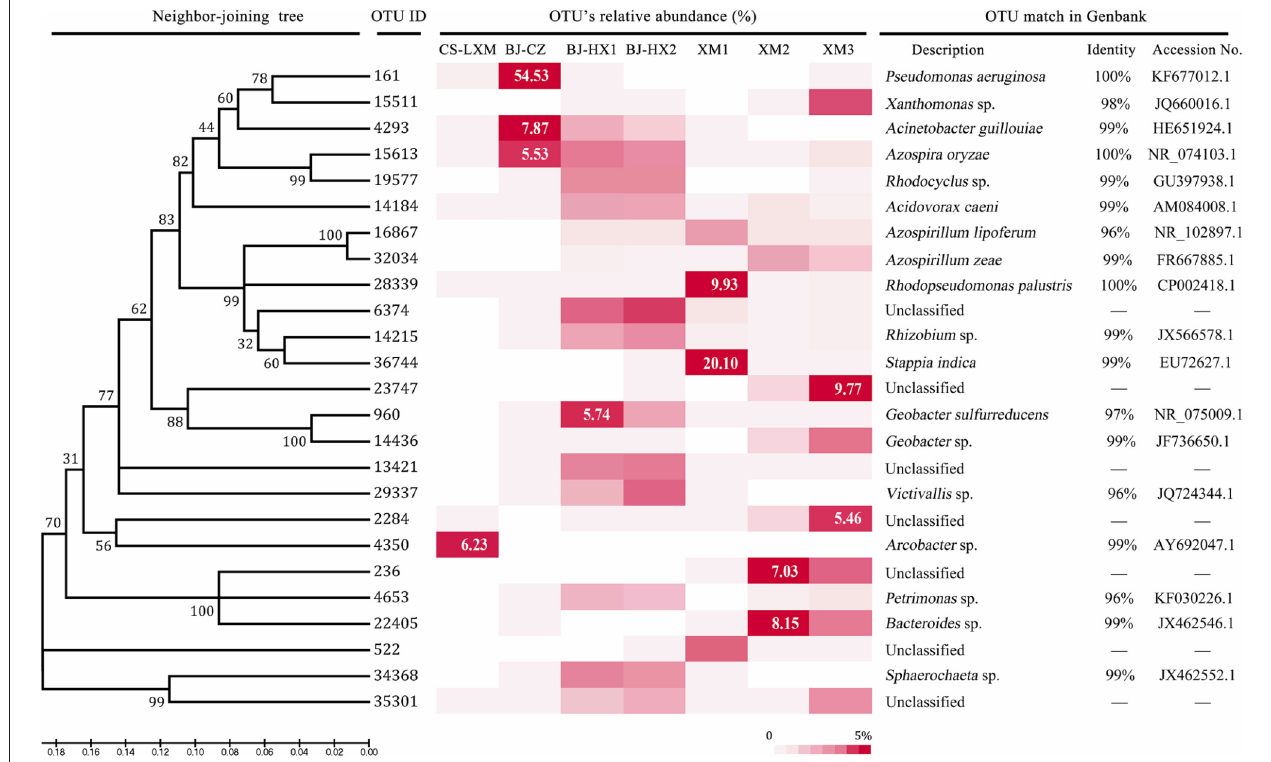
Frontiers in Microbiology |